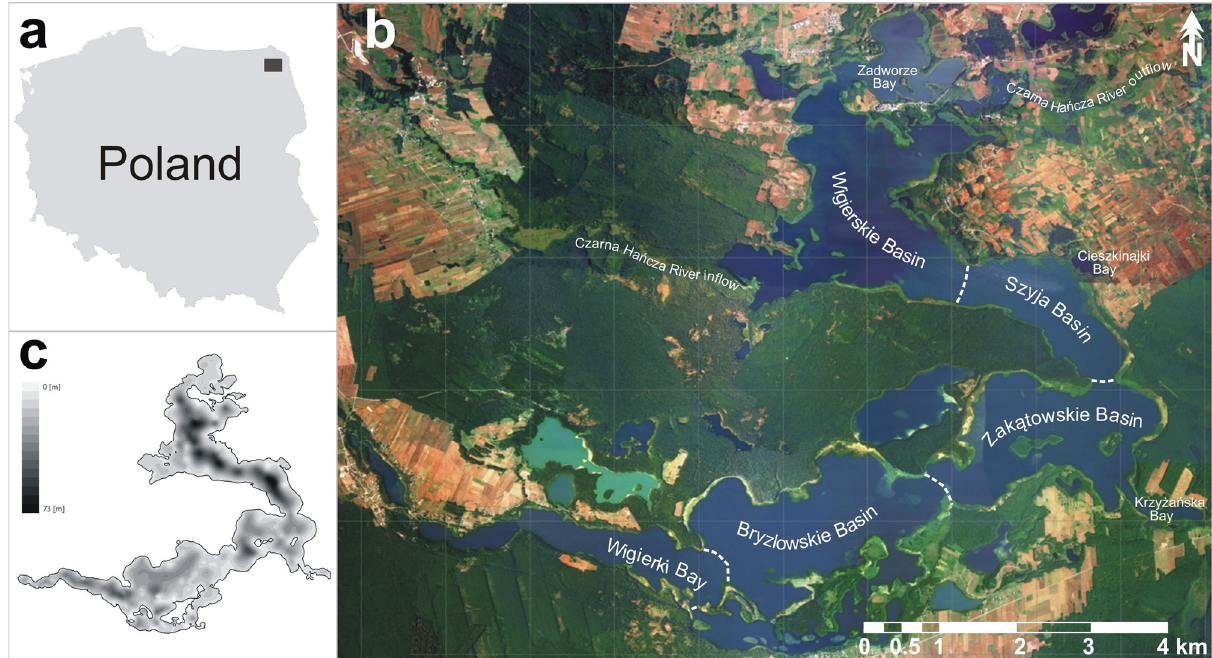
Figure 1. Study area: ( a ) location of the study area (gray rectangle) on the map of Poland; ( b ) Wigry Lake photomap (obtained courtesy of the Wigry National Park authorities) with the designation of five main parts of the lake (Wigierskie Basin, Szyja Basin, Zak ą towskie Basin, Bryzglowskie Basin, and Wigierki Bay) and other important zones (Czarna Ha ń cza River inflow, Czarna Ha ń cza River outflow, Zadworze Bay, Cieszkinajki Bay, and Krzy ż a ń ska Bay); ( c ) bathymetry sketch of the Wigry Lake bottom.